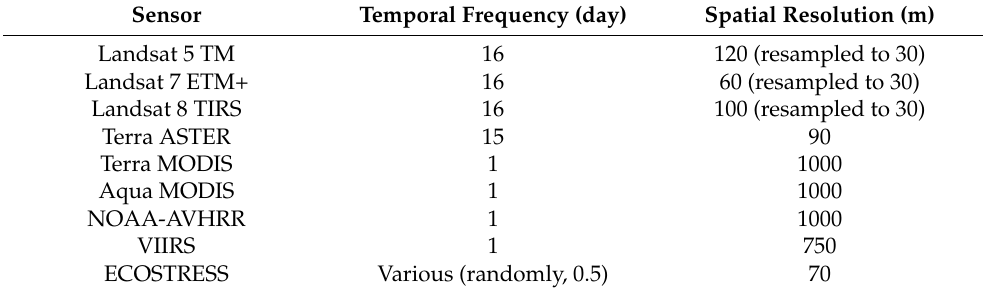
Table 3. The temporal frequency and spatial resolution of the main remotely sensed thermal